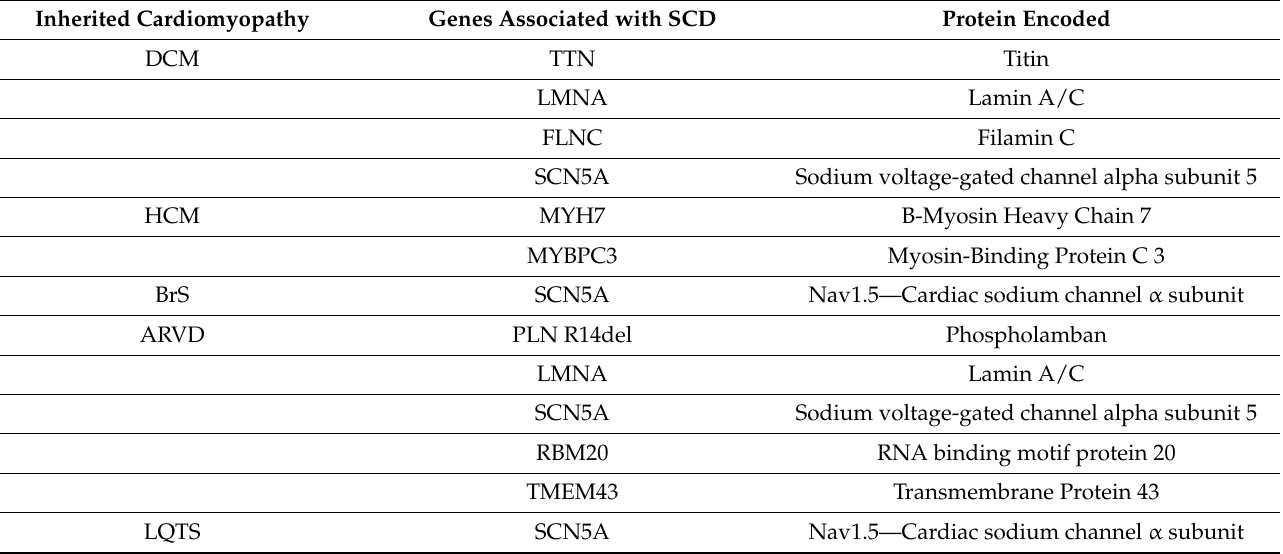
Table 4. Genes associated with an increased risk of malignant arrhythmias and SCD in inherited car-